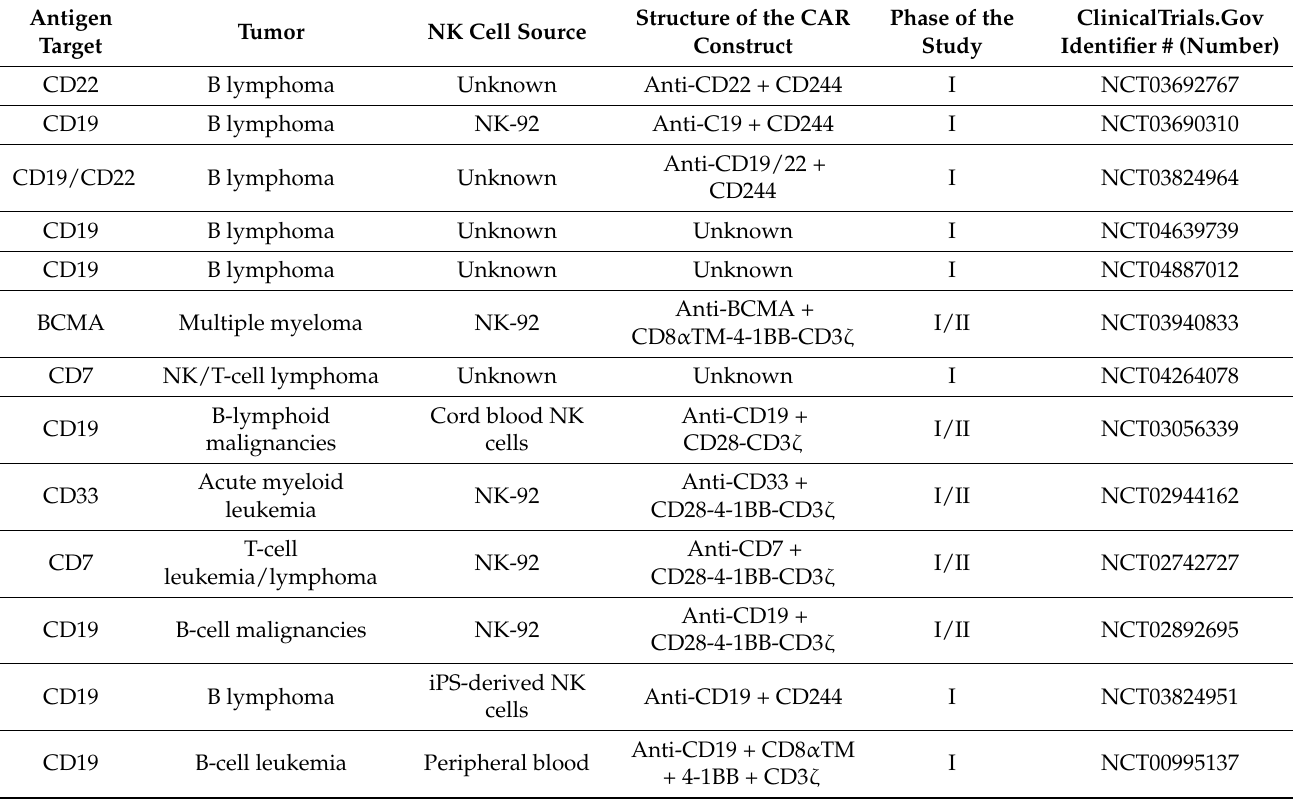
Table 3. Human trials of CAR-NK cells for hematological malignancies listed at ClinicalTrials.Gov (iPS: induced pluripotent stem). Antigen